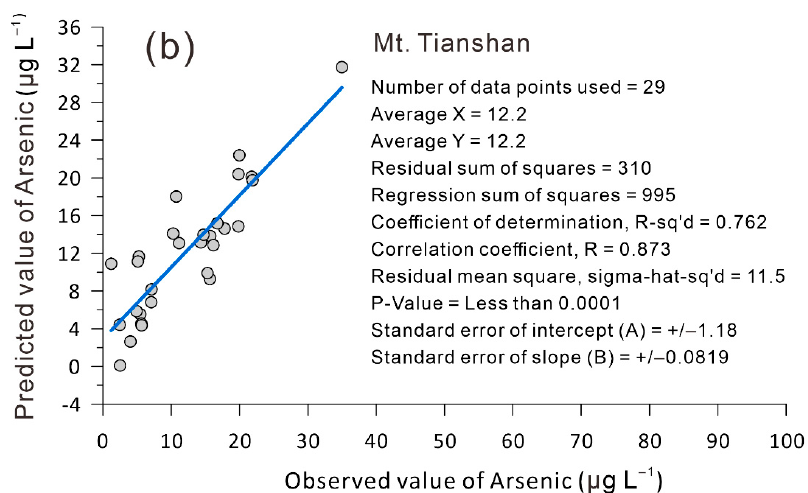
Figure 11. The observed value of arsenic (As) versus the predicated value from the multiple regression mode for waters in the regions of the Altay Mts. ( a ), and Tianshan Mts. ( b ).